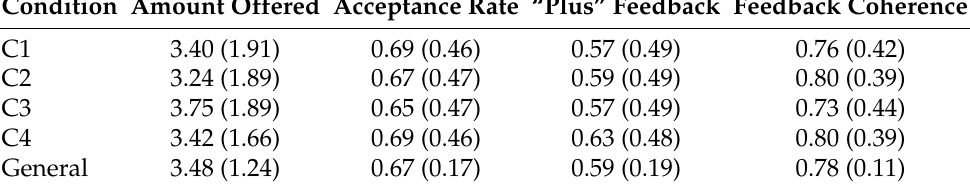
Table 2. Descriptive statistics. In the table are presented means and standard deviation values between brackets for all the game-related variables within each experimental condition.